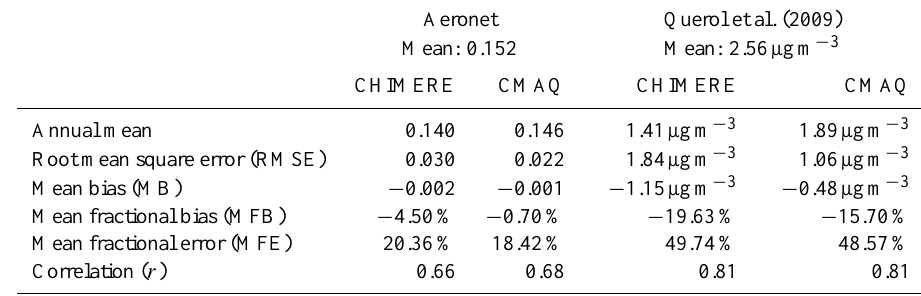
Table 2. Summary of the annual statistical evaluation for AOD at 550nm from the Aeronet network and SSA ground-level based observations of PM 10 (µgm − 3 ) included in Querol et al. (2009) ∗ .